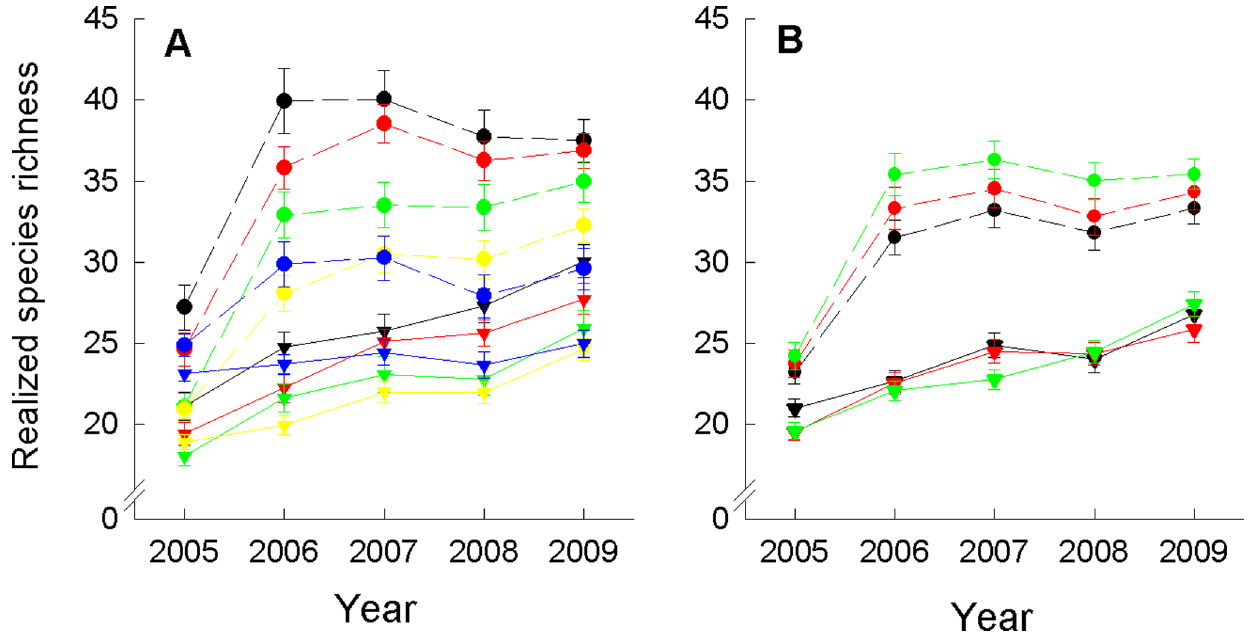
Figure 2. Realized species richness. Realized species richness as a function of time (A) as mean values ( 6 1SE) per sown species-richness level across colonization periods, and (B) as mean values ( 6 1SE) per colonization period across species-richness levels. For symbols see Figs. 3 and